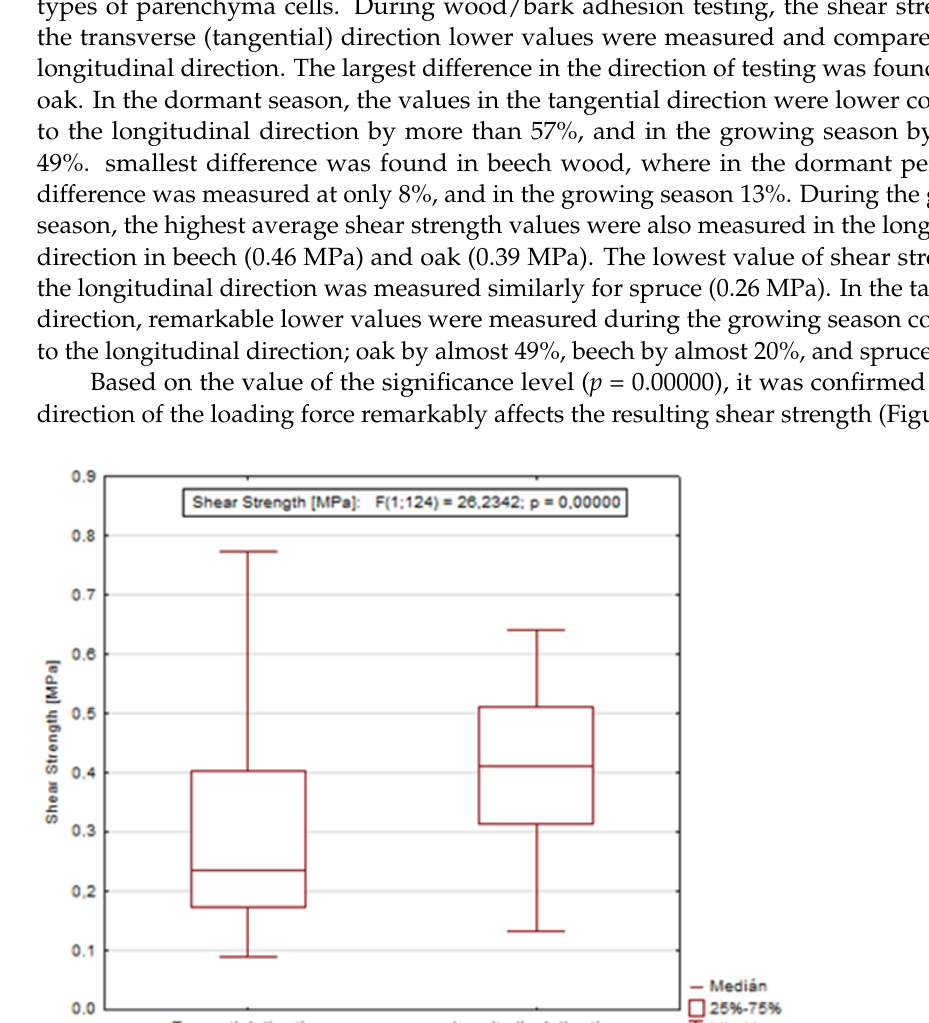
Figure 6. Graph showing the dependence of shear strength on the direction of loading during dormant and growing season.